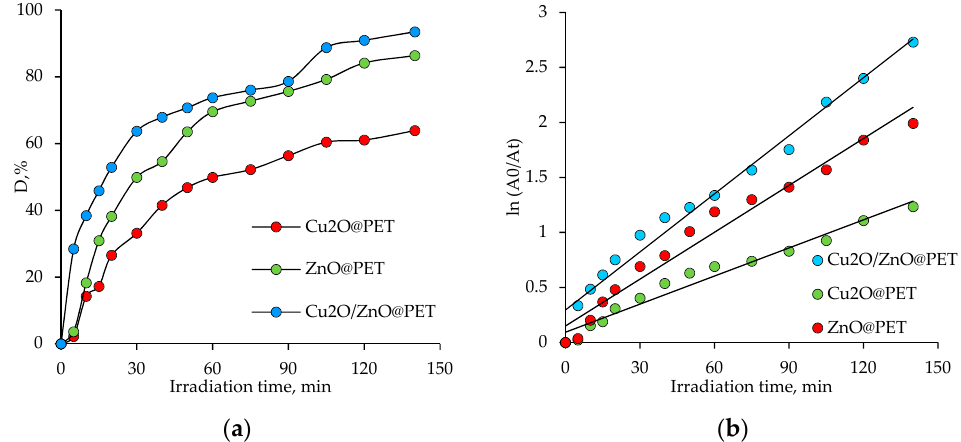
Figure 8. The variation in the degree of Czm degradation (D, %) as a function of irradiation time in the presence of different composite catalysts (2 × 2 cm 2 , Czm feed, concentration: 1.0 mg/L) ( a ), and Langmuir–Hinshelwood plots for photodegradation of Cmz catalyzed by different composites ( b ).